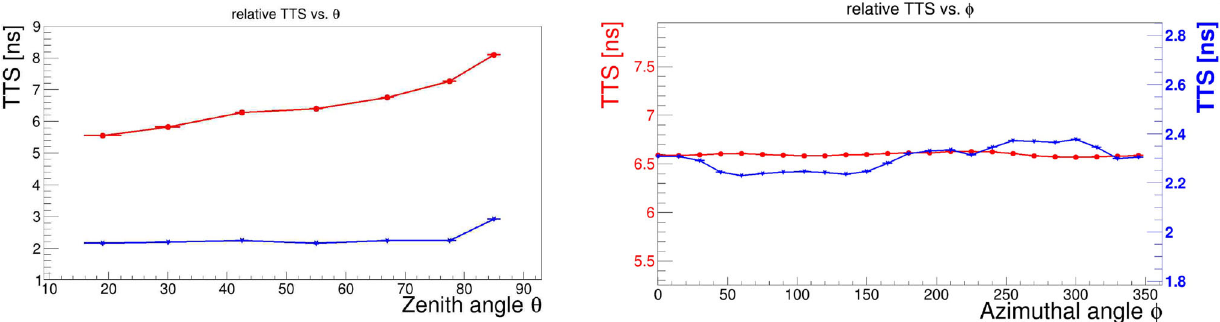
Fig. 41 Uniformity of the relative TTS ( σ ) along the zenith ( θ , left) and azimuthal angle ( φ , right) on average of all scanned PMTs with the same zenith or azimuthal angle. Blue: HPK PMTs; red: NNVT PMTs